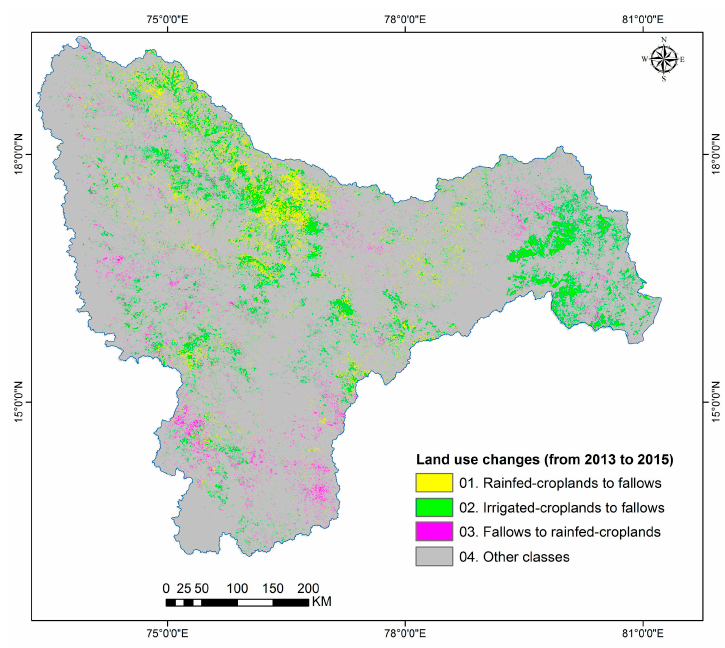
Figure 6. Land use changes from 2013–2014 to 2015–2016.